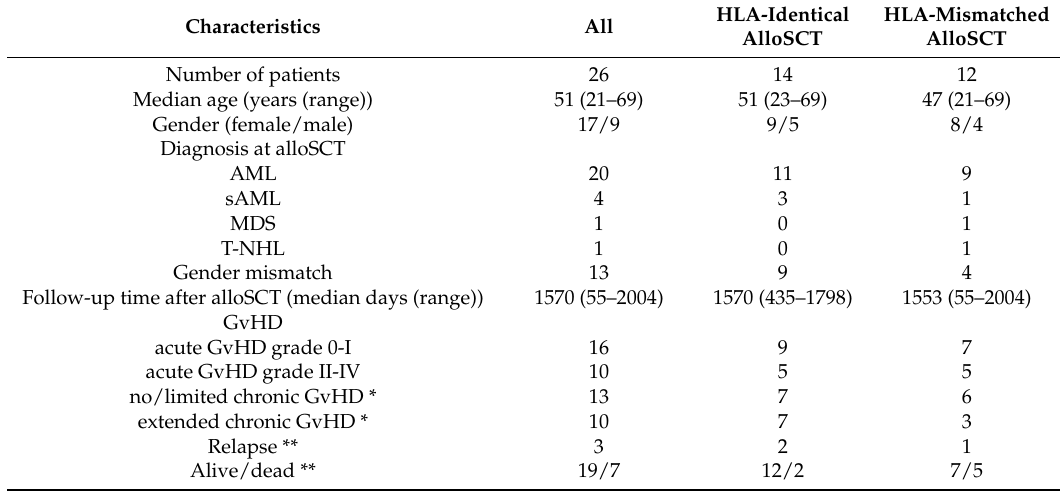
Table 1. Demographic characteristics of alloSCT patients. * Manifestation of chronic GvHD could not be evaluated for three patients due to death prior to the possible manifestation of chronic GvHD; ** Within the first year after alloSCT one out of three patients had a relapse and four out of seven patients died.